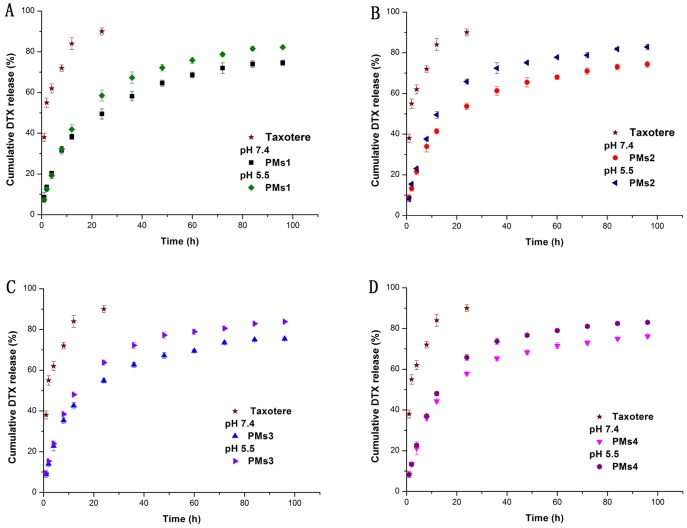

In vitro release profile of DTX from the four types of PMs solution at 37°C in PBS (10 mM, pH 7.4) or PBS(10 mM,pH 5.5), in comparison with Taxotere. (n = 3).